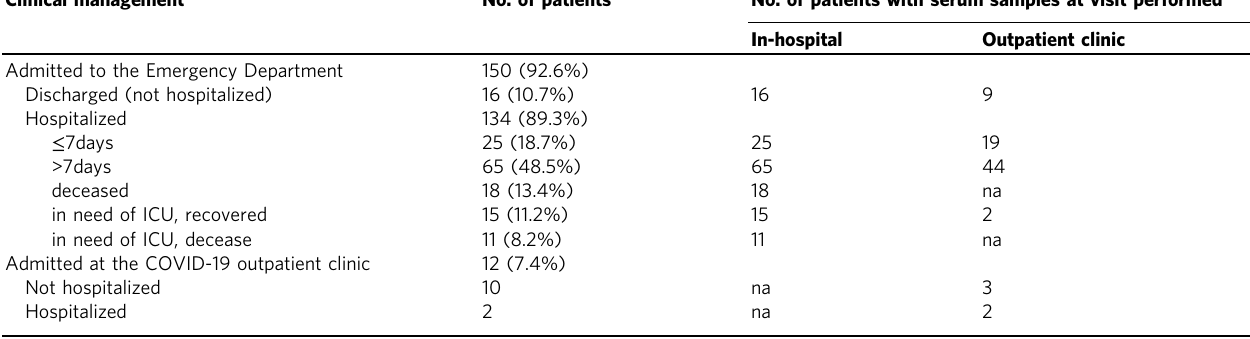
Table 1 Clinical management and serum samples availability of 162 COVID-19 study